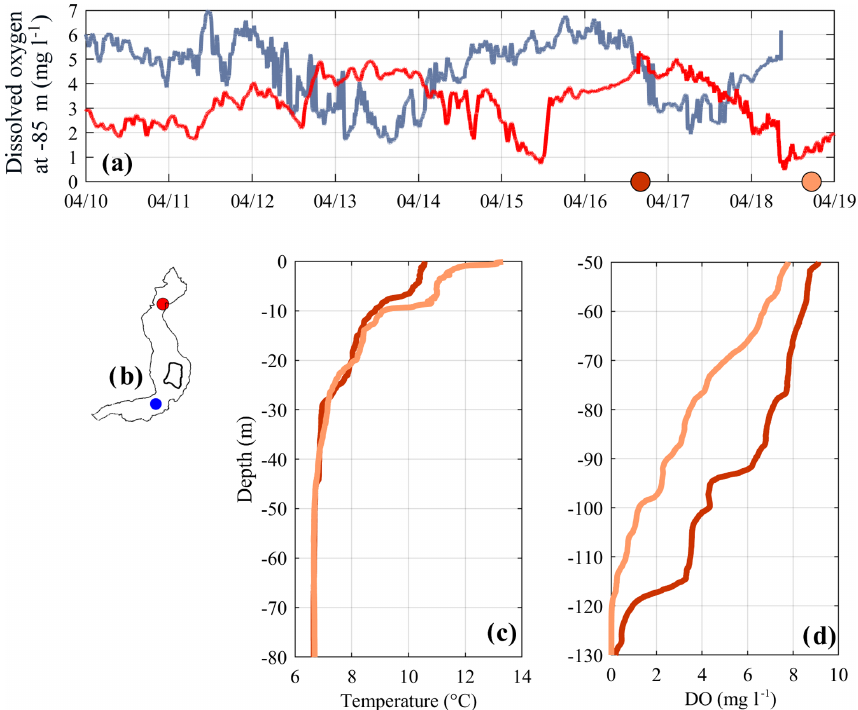
Figure 8. (a) Time series of DO measured at 85m in depth on April 2018. Red and blue lines refer to the northern and southern sampling locations, respectively (see b ). Colored dots on the x axis indicate the sampling time of the vertical profiles shown in (c–d) . Panel (c) compares the profiles of temperature between 0 and 80m in depth at LS-N, while panel (d) compares the profiles of DO between 50 and 130m at